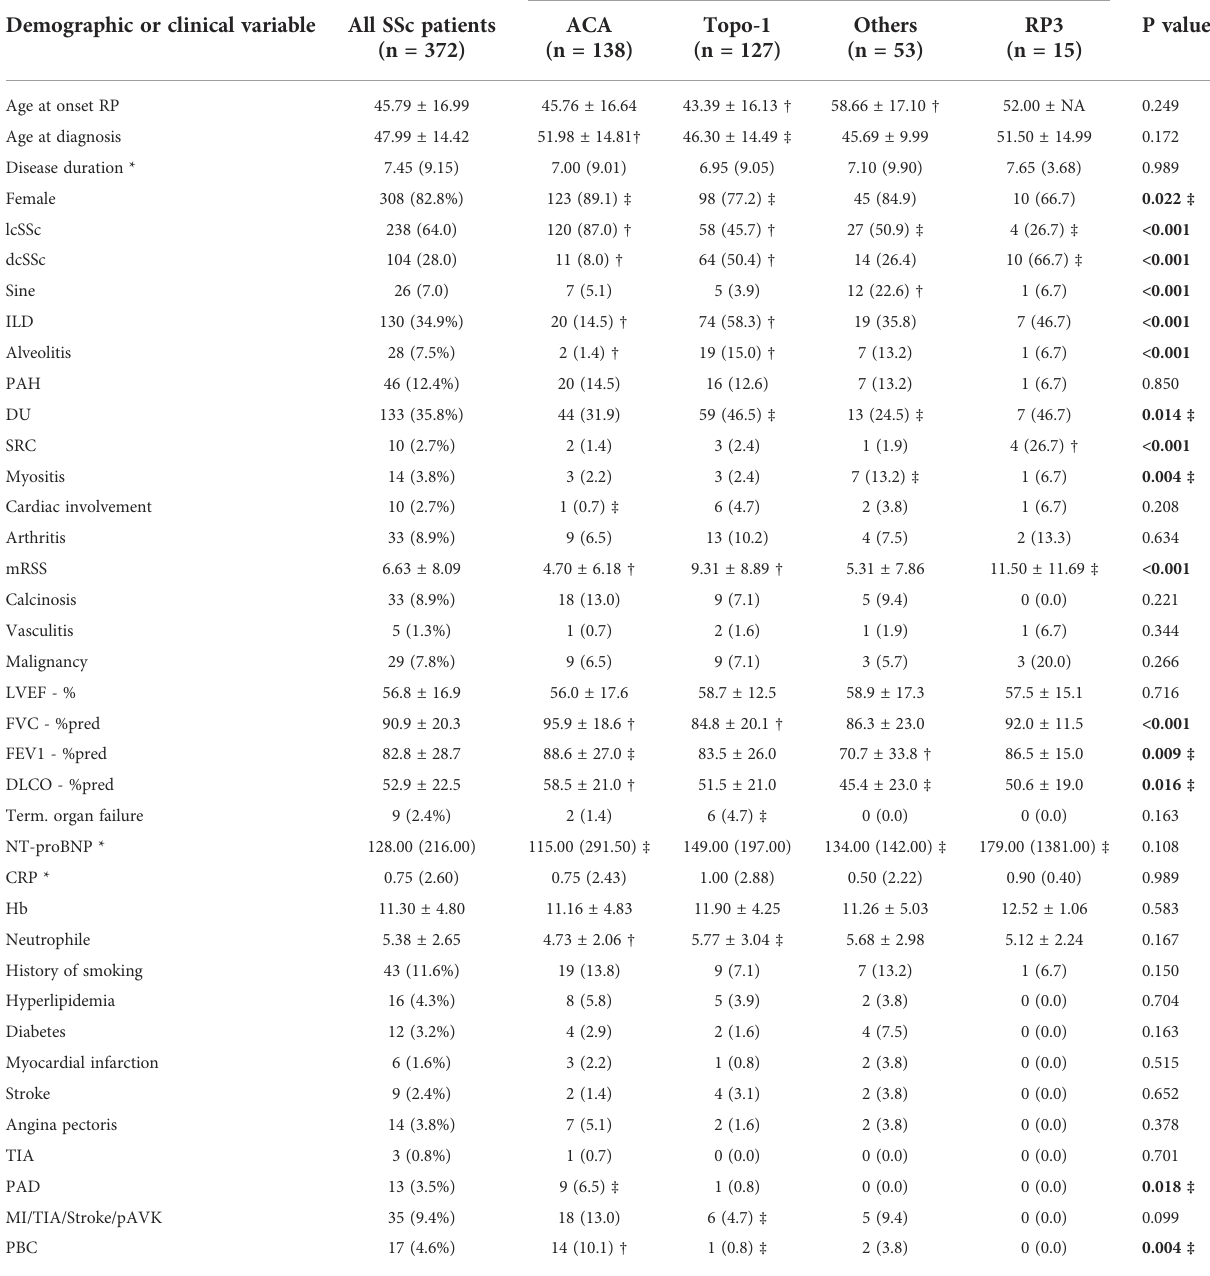
TABLE 3 Clinical manifestations of SSc